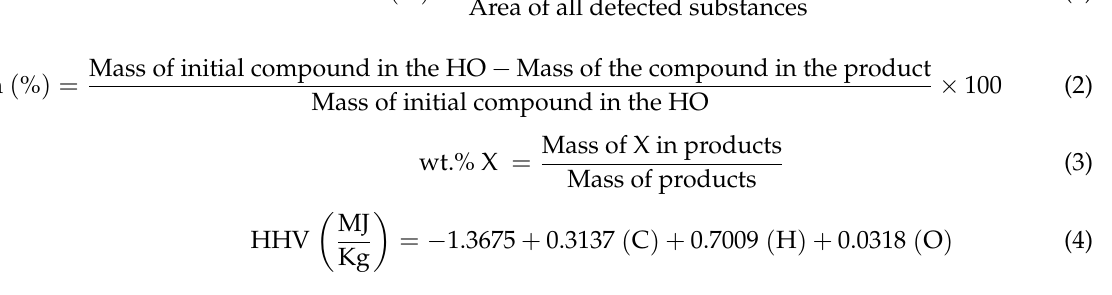
Figure 5. Experimental images for the procedure of conducting the catalytic deoxygenation reactions for the hydrolyzed oil of Chlorella vulgaris microalgae.